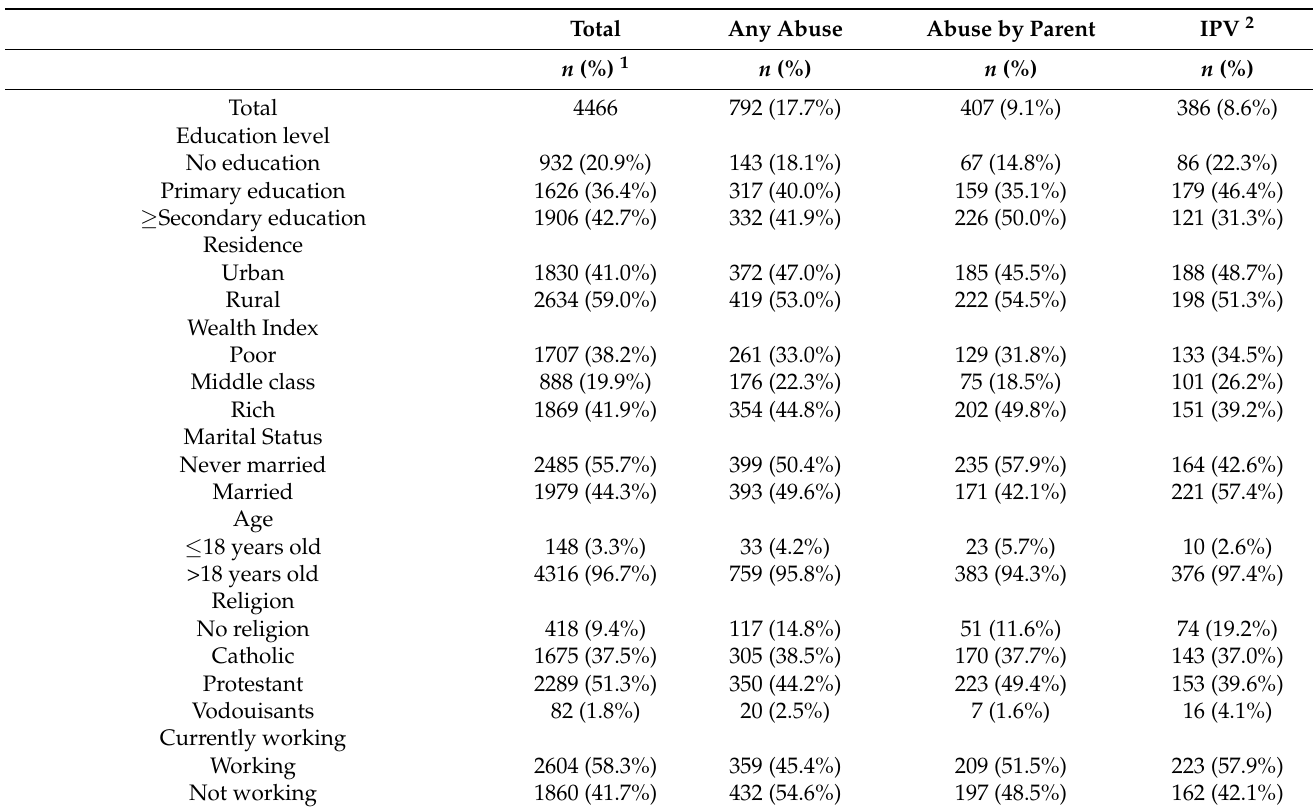
Table 1. Characteristics of Haitian women based on type of exposure to domestic